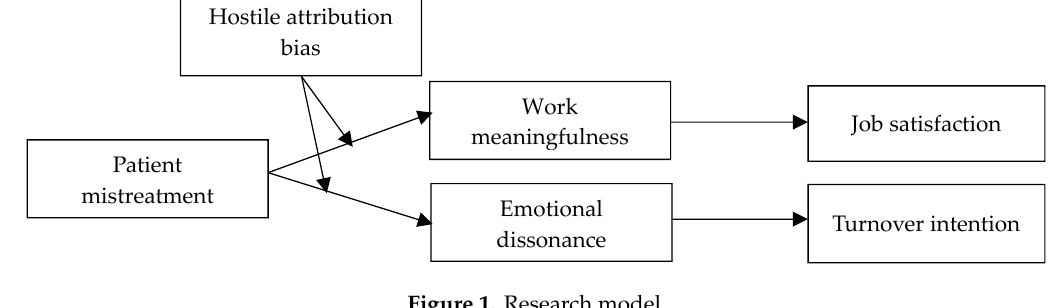
Figure 1. Research model.